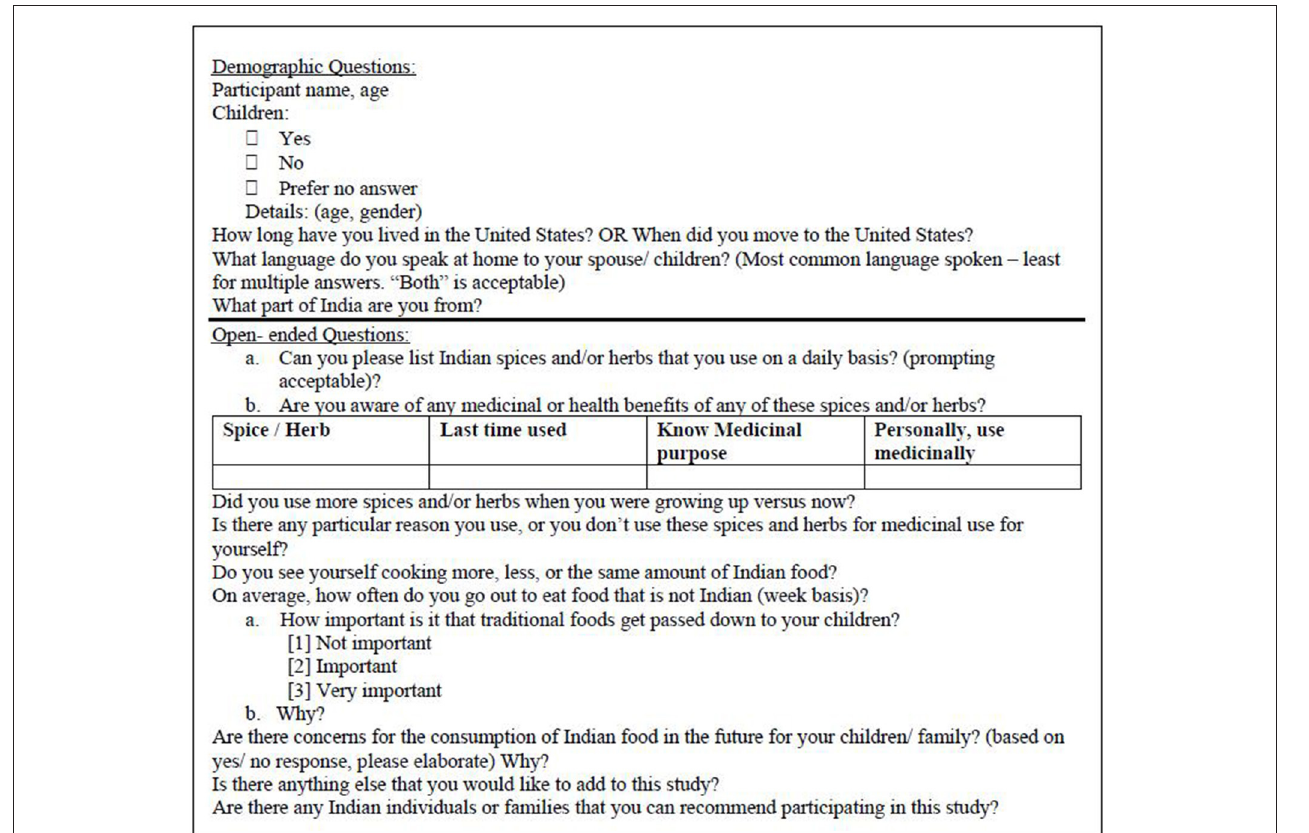
FIGURE 1 | Questionnaire administered to 31 Indian immigrant women in Southern